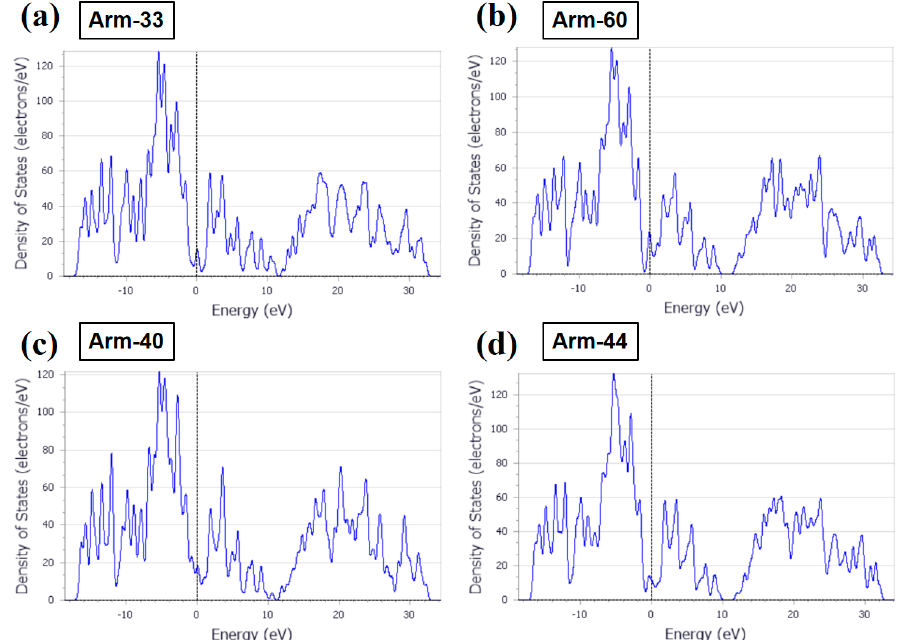
Figure 3. The density of states (DOS) of ( a ) arm-33, ( b ) arm-60, ( c ) arm-40, and ( d ) arm-44, respectively. The dotted line represents the Fermi level.